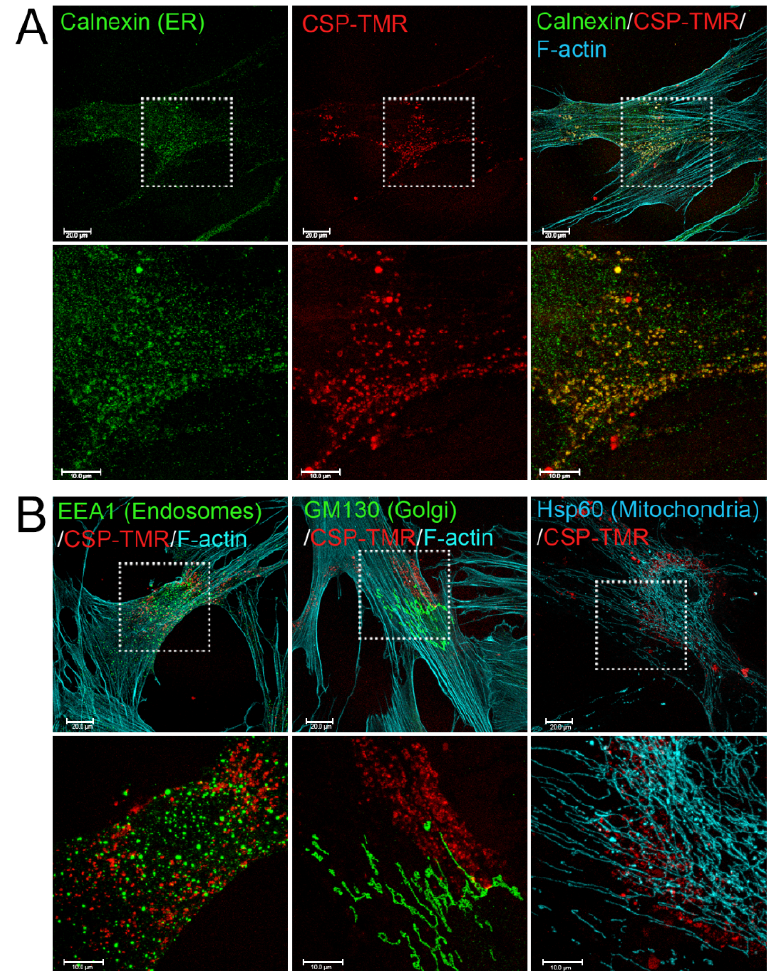
Figure 1. Internalization and Subcellular Distribution of fluorescent-labeled CSP in human IPF-Lfs. hIPF-Lfs were treated with tetramethylrhodamine-conjugated CSP (CSP-TMR, 10 µ M) for 2 days and then immunostained with organelle makers such as Calnexin for endoplasmic reticulum (ER), EEA1 for early endosomes, GM130 for Golgi, and Hsp60 for Mitochondria. Lower panels in ( A , B ) show higher magnification of the boxed areas of the upper panels. Scale bars are 20.0 µ m (lower magnification images) and 10.0 µ m (higher magnification images), respectively.